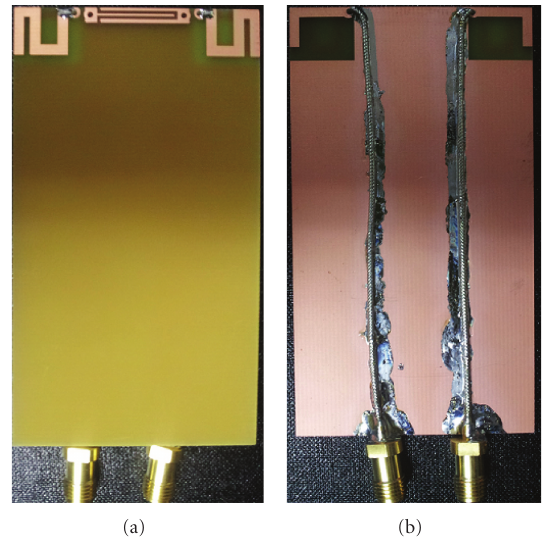
Figure 7: Photograph of fabricated MIMO antenna: (a) top view, (b) bottom view.